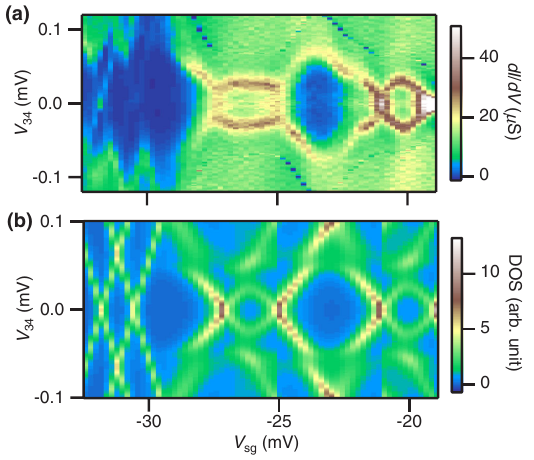
FIG. 5. Comparison between data and calculation. (a) Magni- < − 19 mV. (b) Calculation of the fied data plot in − 33 < V sg DOS on the QD in the same V range. The QD is restricted to 4 sg levels, with negative (positive) interaction for the bottom (upper) 2 levels in band 1